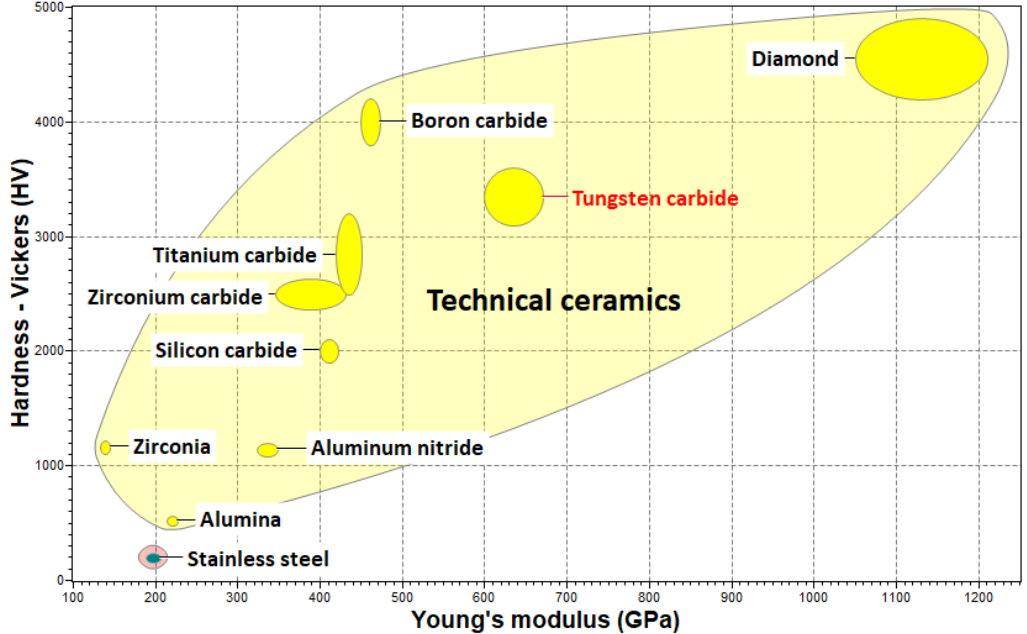
Figure 1. Ashby diagram of Hardness (Hv) versus Young’s Modulus (GPa) for technical ceramics [8] WC exhibits higher hardness and stiffness than most existing technical ceramics. Reprinted with permission from [8]; 2019 CES EduPack.